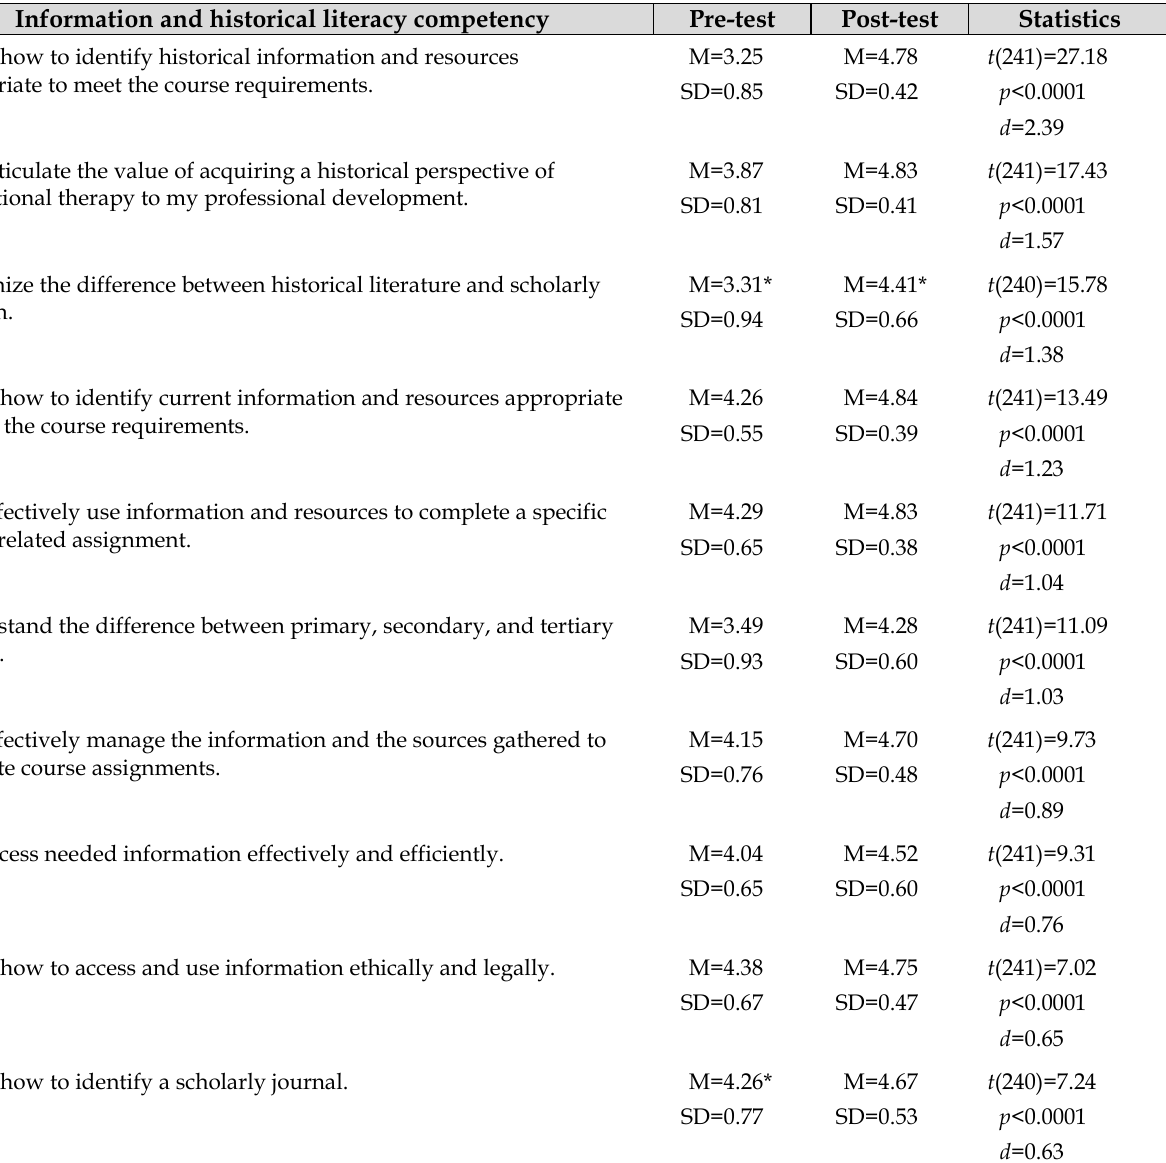
Table 1 Information and historical literacy competence questionnaire: pre- and post-test